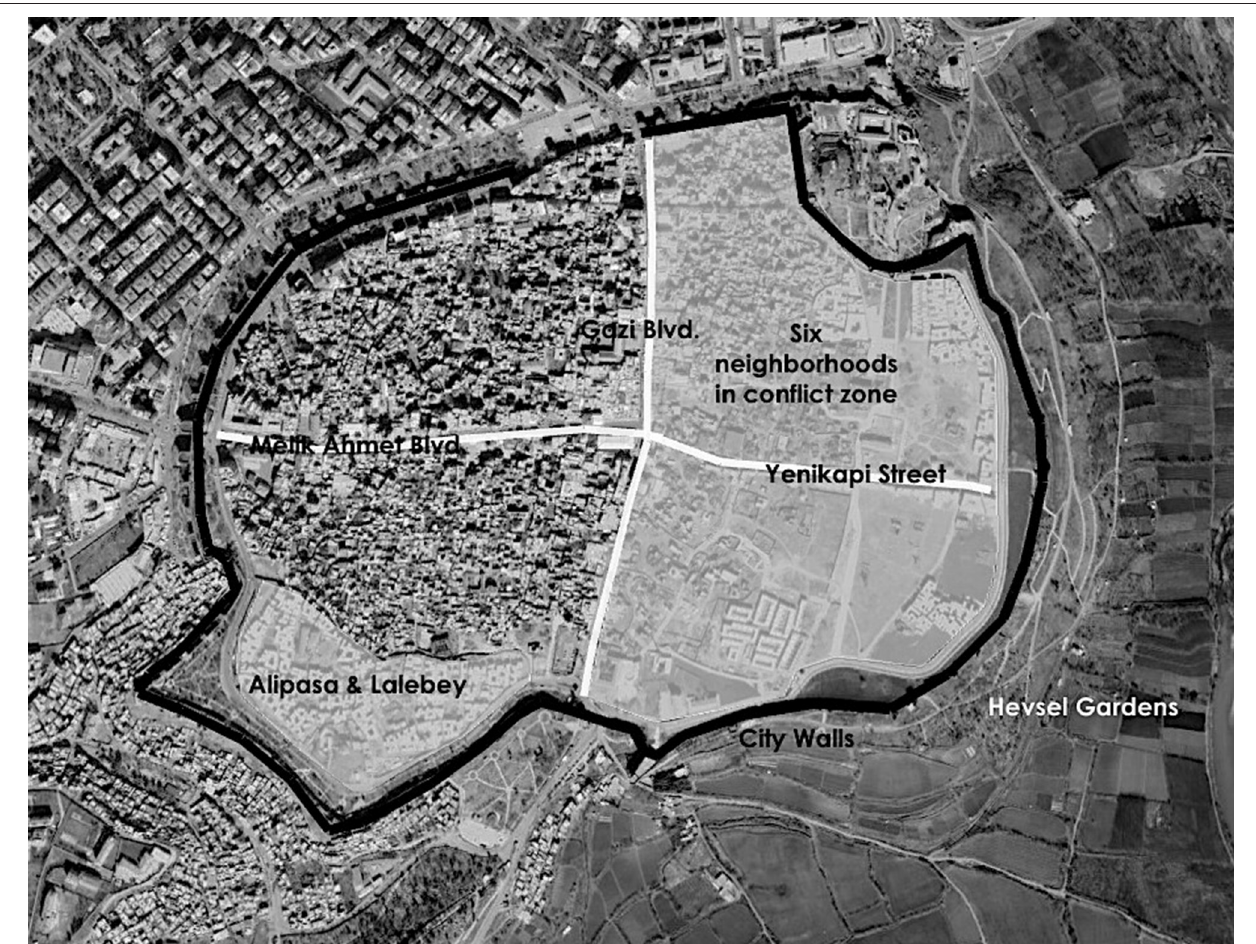
FIGURE 1 | Suriçi area with City Walls, Hevsel Gardens, main roads and demolished area. Maps data: Google Earth, © 2022 Maxar